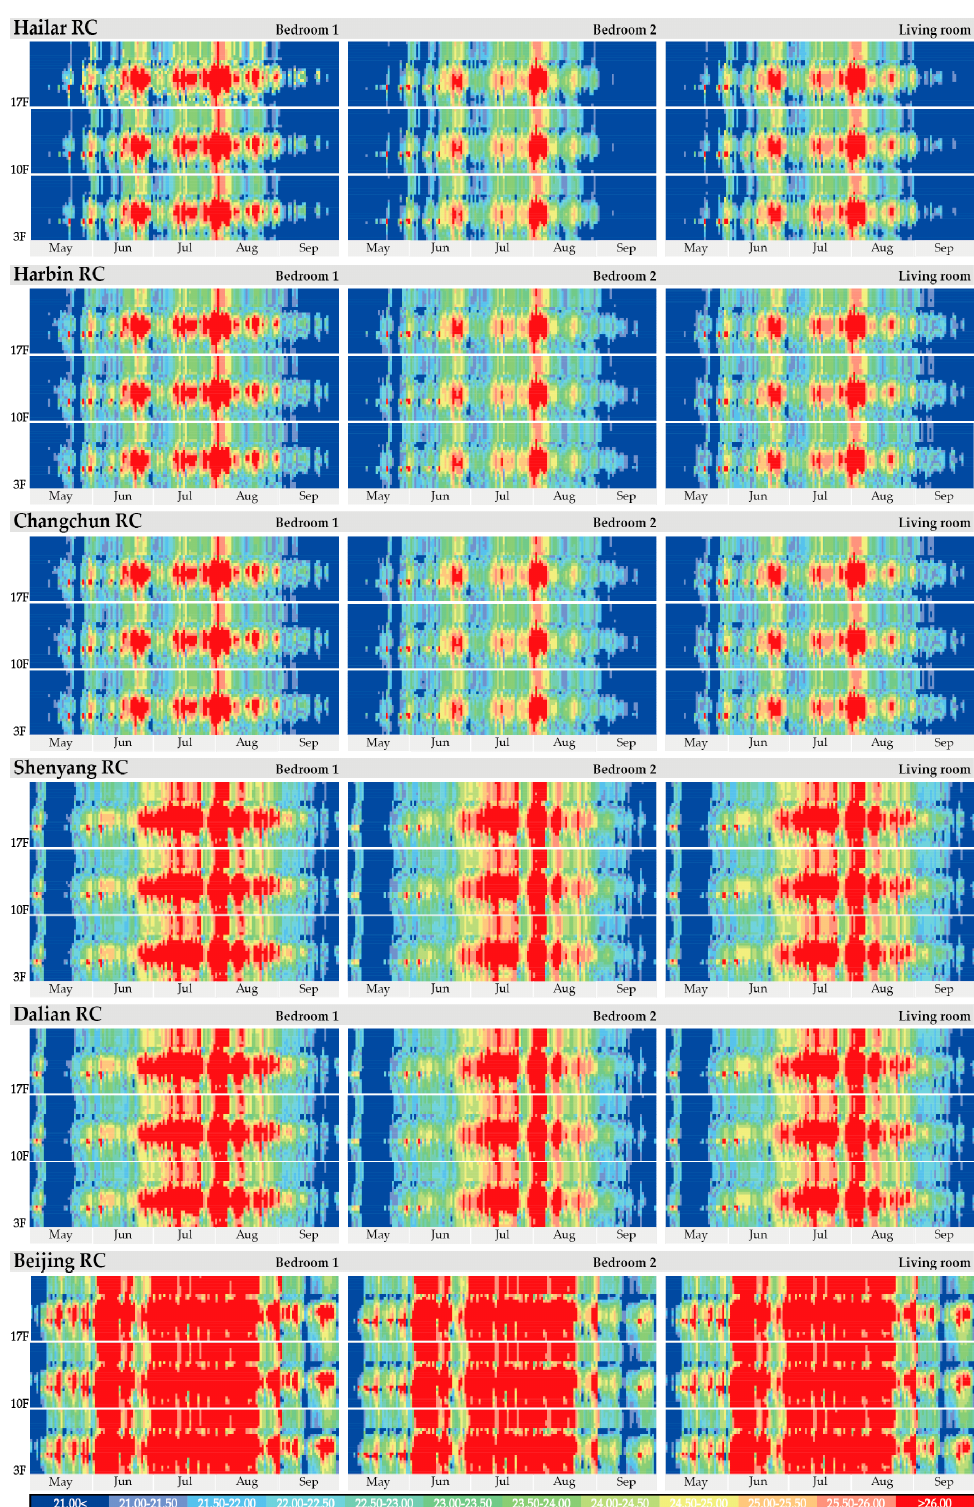
Figure 9. Operative temperature (°C) of 3F, 10F, and 17F in RC buildings of six cities.